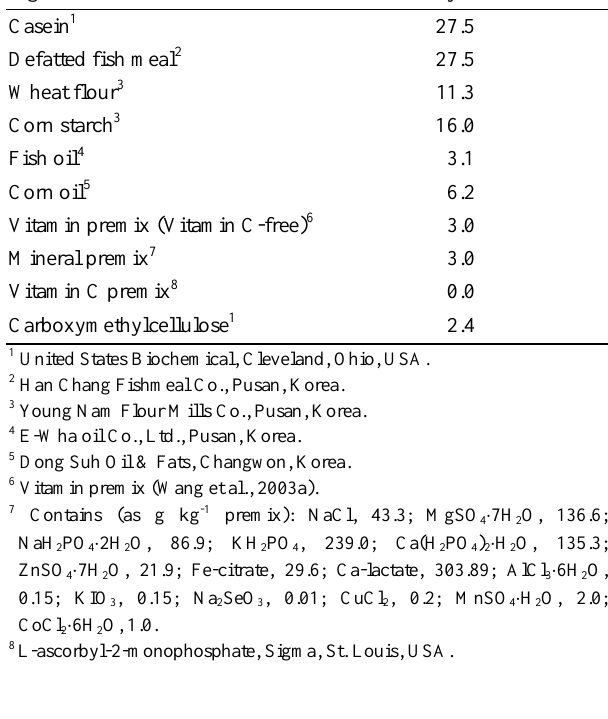
Table 1. Composition of the basal diet for juvenile eel